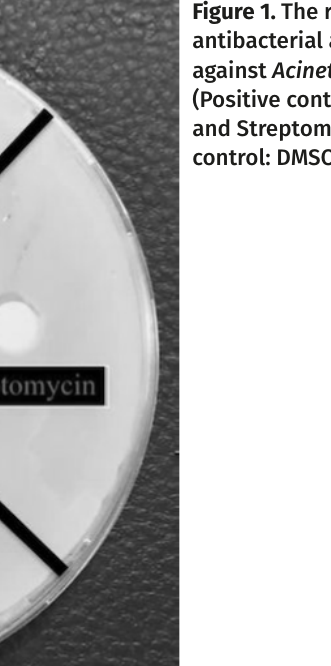
Figure 1. The results of antibacterial activity of SMEO against Acinetobacter baumanii (Positive controls: Tetracycline and Streptomycin, Negative control: